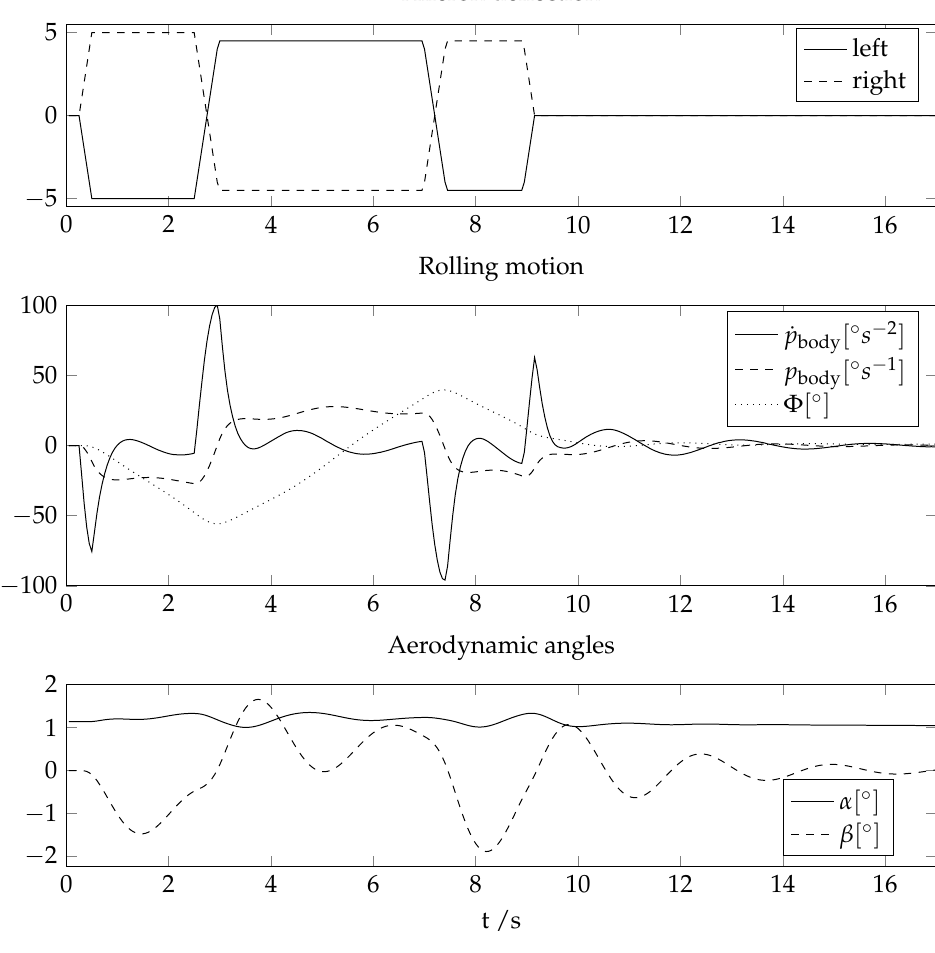
Figure 12. Time signals for the bank to bank